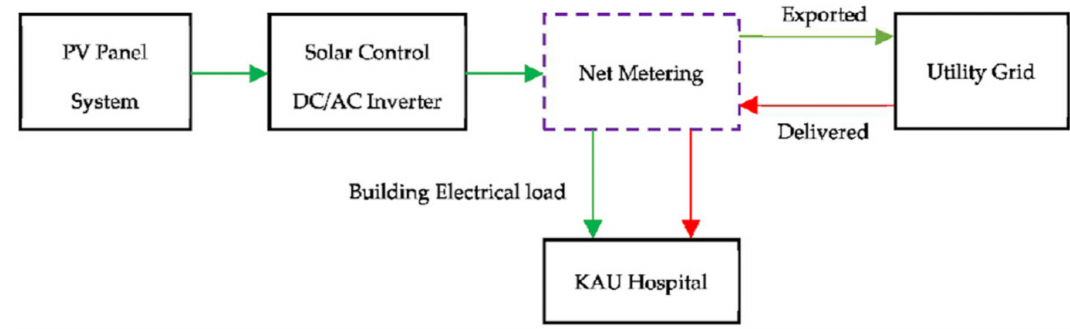
Figure 4. On grid solar power system for KAU